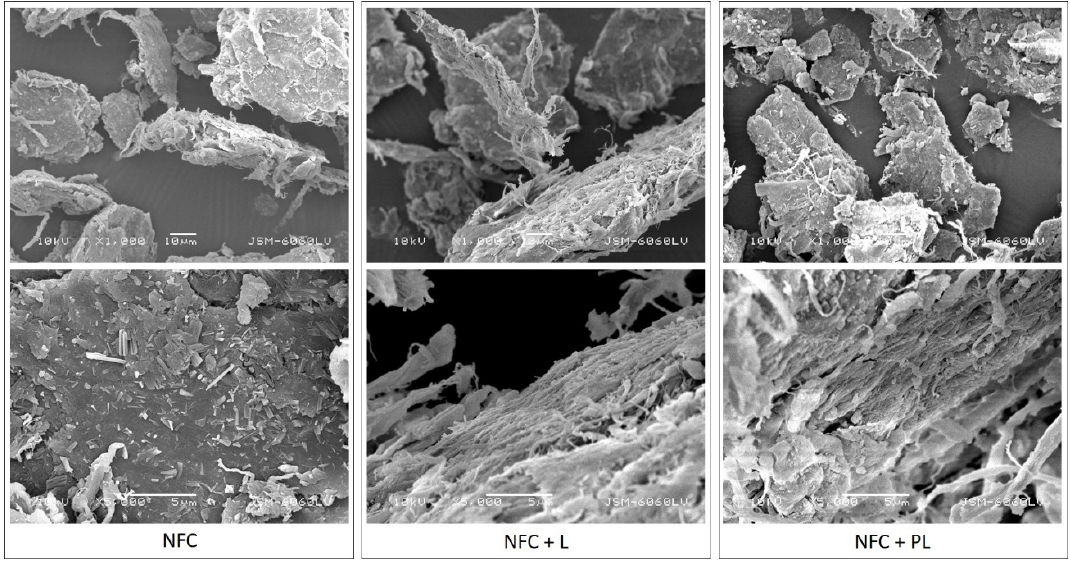
Figure 1. SEM images of NFC, NFC + L, and NFC + PL (magnification: 1000× (top) and 5000× (bottom)).